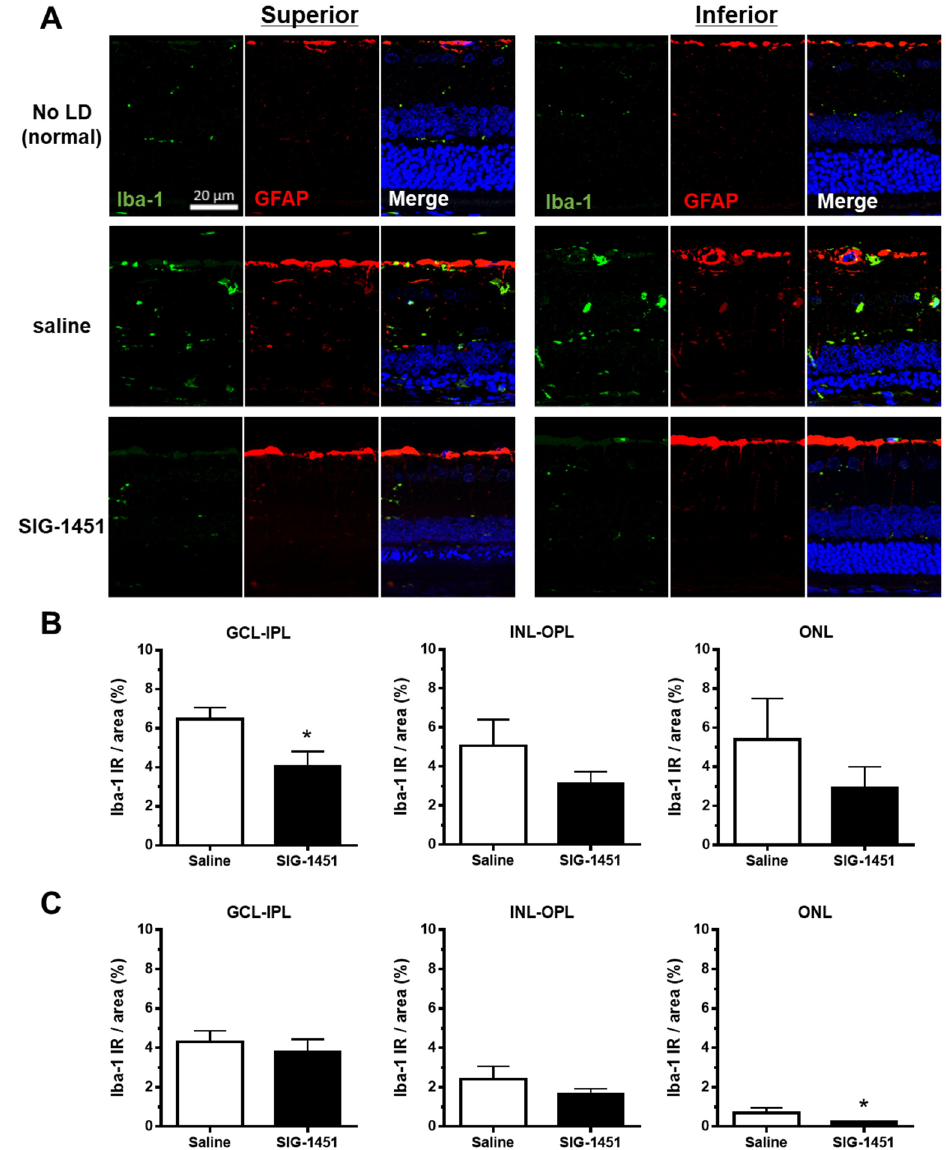
Figure 3. Iba-1 and GFAP immunohistochemistry in retinas from rats injected intraperitoneally with saline or SIG-1451. ( A ) Fluorescent microscopy images showing Iba-1 and GFAP immunoreactivity in the retina ( A ). Percentage of Iba-1 immunoreactive area to the total measured area of the superior ( B ) and inferior ( C ) parts of the retina. Data are represented in terms of the mean ± SE values (saline: n = 10, SIG-1451: n = 13, unpaired t -test; * p < 0.05). GCL: ganglion cell layer, IPL: inner plexiform layer, INL: inner nuclear layer, OPL: outer plexiform layer, ONL: outer nuclear layer.